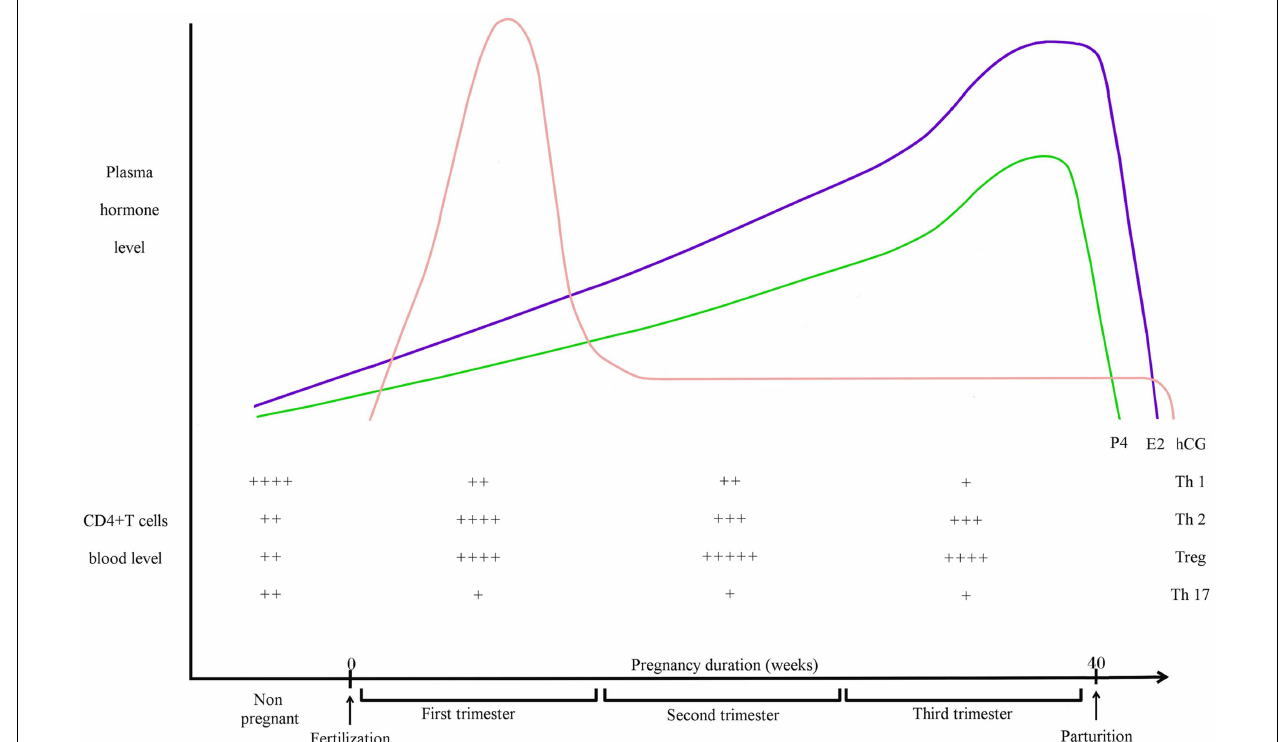
quantities of P4 are already produced at the follicle stage.Then, P4 concentration in the blood increases strongly during the course of pregnancy to reach a peak before parturition. Relative blood levels of CD4 + T cells are compiled from different articles. During healthy pregnancy,Th1 cells are downregulated whileTh2 cells are upregulated (13).Th2 predominance is considered to be essential for fetal survival. Pregnancy is also associated with a systemic expansion ofTreg cells.The level ofTreg cells is on the peak during the second trimester (14, 15).The circulating level ofTh17 cell does not vary during human pregnancy and stays low (16).They are decreased during pregnancy when compared to non-pregnant women